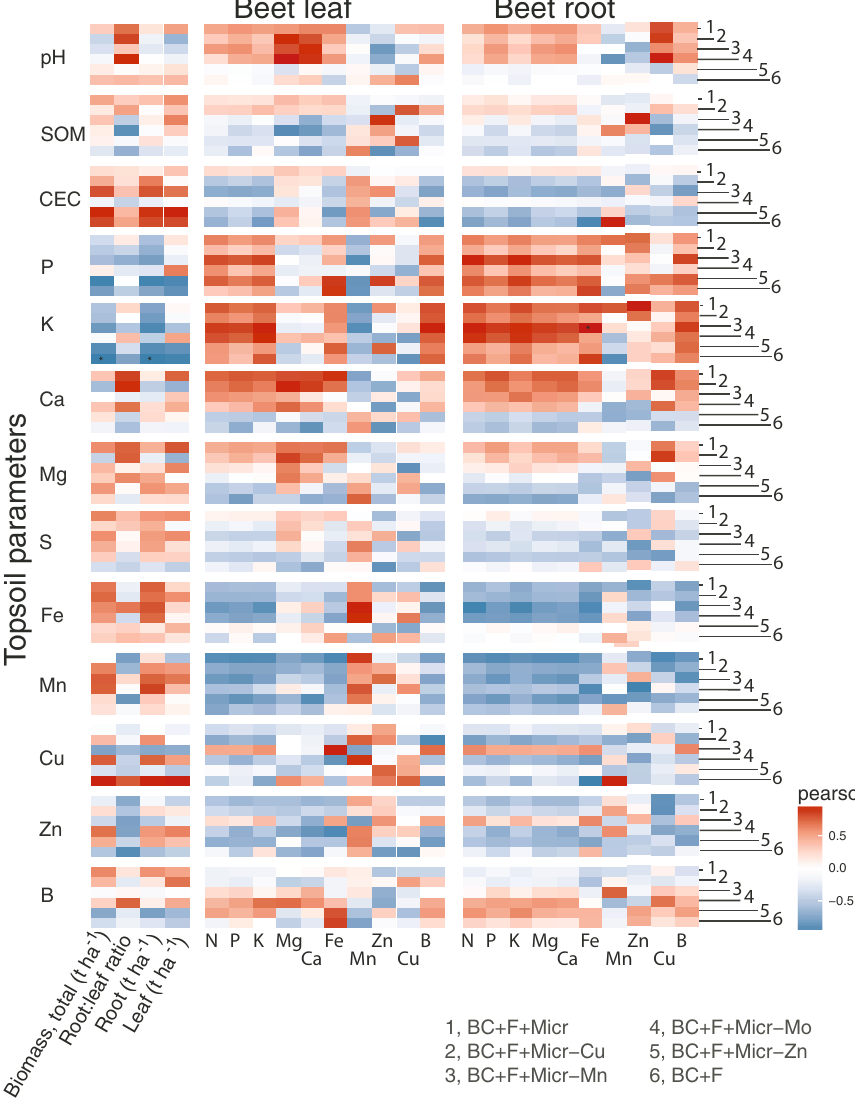
Figure 6: Correlations between elemental concentrations in the topsoil and beet leaf or root for all biochar treatments ( 2016 and 2017 beet crops ) . A similar analysis for subsoil can be found in the Supplementary Data Figure